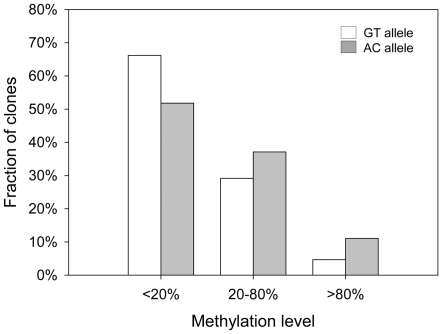
Fraction of clones with different methylation levels.The fraction of the GT allele bearing clones and that of AC allele containing clones are depicted in white and grey bars, respectively. The methylation level was calculated by dividing the number of methylated sites by the number of possible methylation sites in a single clone. As expected for a CpG island, the majority of clones are weakly methylated (<20%), but heterogeneously (20–70%) and highly methylated clones (>80%) were also observed. The AC allele showed a lower abundance in weakly methylated clones and a higher abundance in heterogeneously and highly methylated clones compared to the GT allele (P<0.001, Chi-square-test).